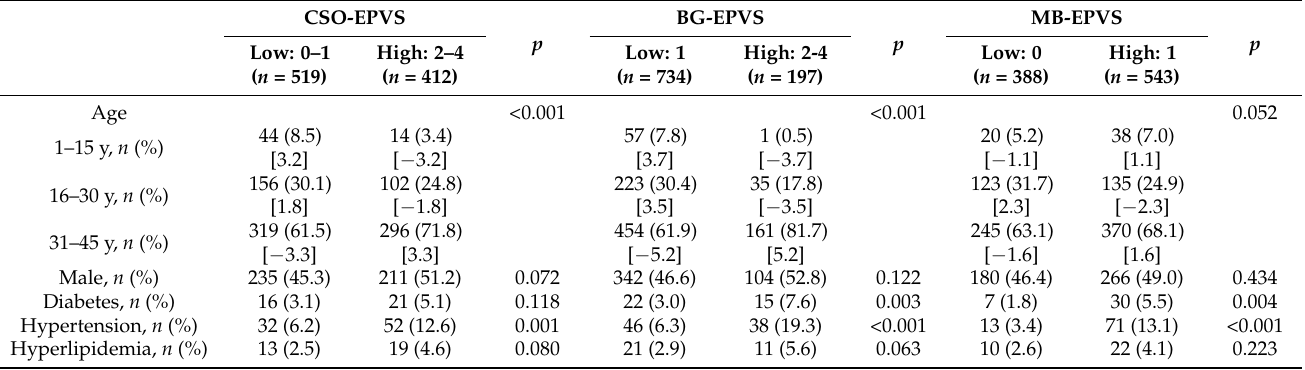
Table 2. The results of the chi-square analysis of the differences in the demographics, vascular factors, and MRI findings between the groups according to the degree of